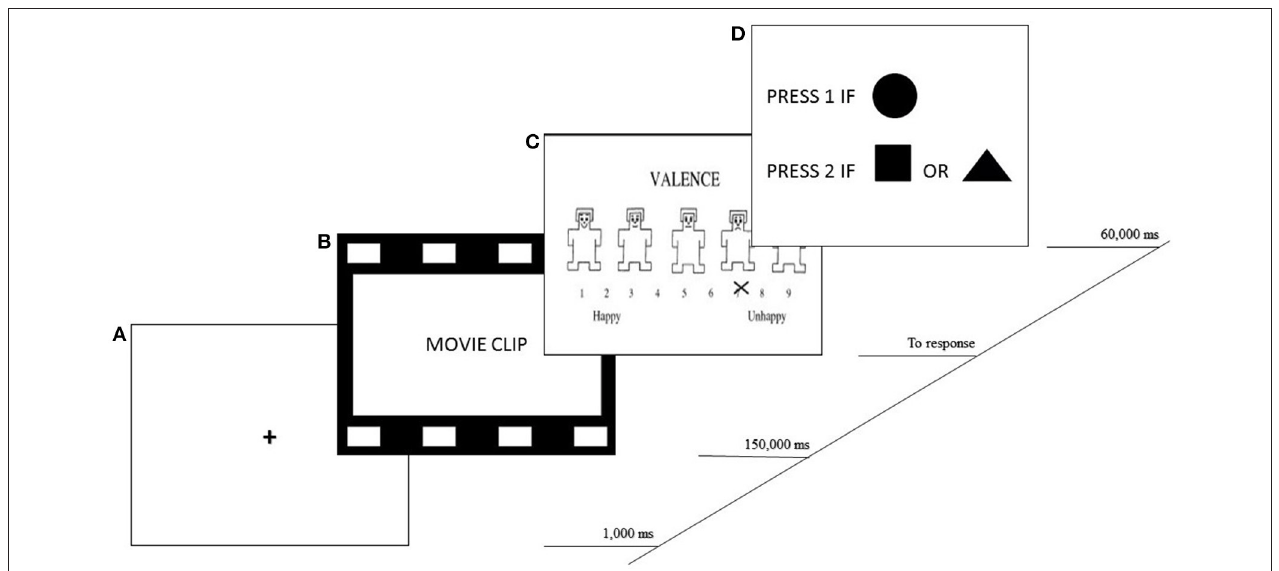
FIGURE 1 | Example of sequence. Time course of events in one sequence. (A) Fixation cross. (B) Mean length of exposure to the clip. (C) Completion of the self-assessment manikin (SAM). (D) Distraction task.